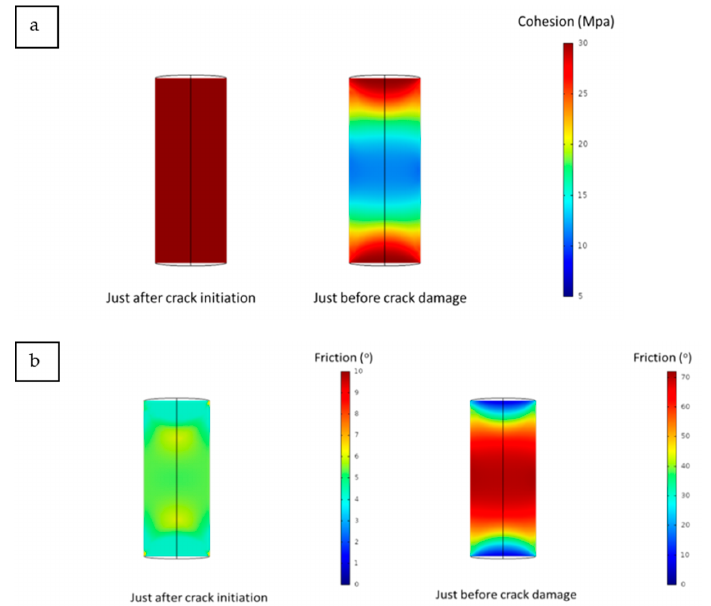
Figure 7. Simulated evolution of cohesion and friction in uniaxial compression test: ( a ) Simulated evolution of cohesion; ( b ) Simulated evolution of friction.